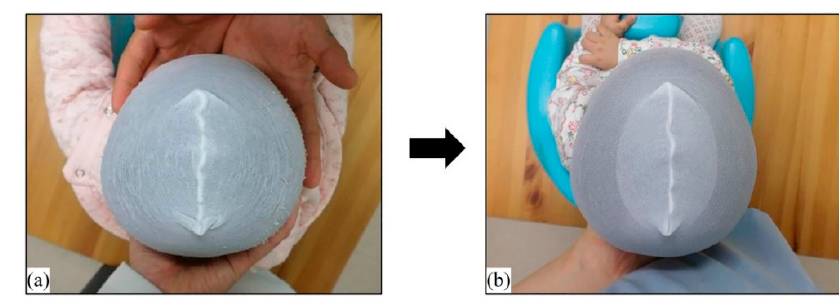
Figure 4. A 4-month-old male infant with brachycephaly ( a ). The patient’s CI was within the normal range after 4 months of orthotic helmet therapy ( b ). Table 3. Effects of helmet therapy according to age at treatment initiation and severity of brachycephaly (paired t-test).